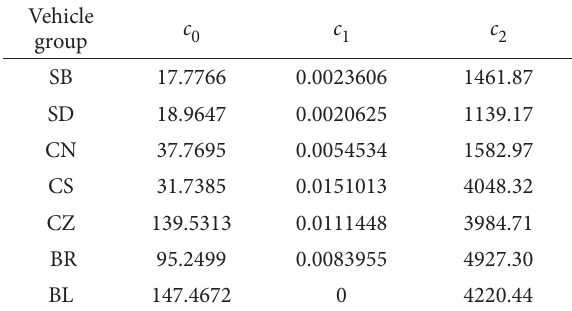
Table 5. Correction coefficients ( WK ) on account of longitudinal gradient for different vehicle groups Vehicle v group